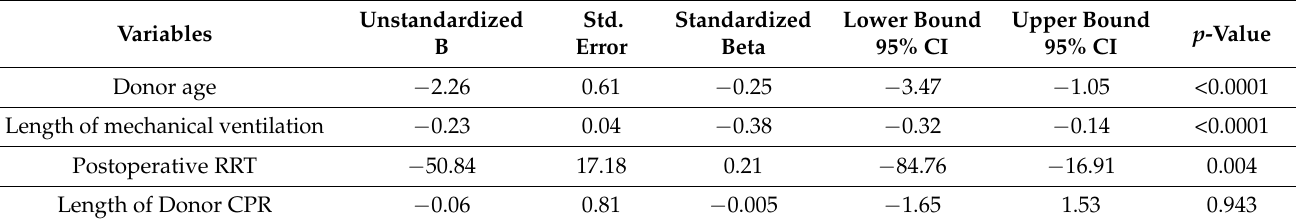
Table 2. Multivariate linear regression for the association between length of donor-CPR and DAOH at one year after heart transplantation.